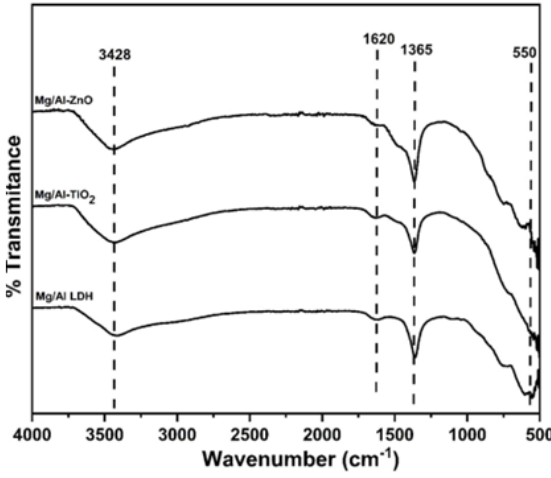
Fig. 9. FTIR spectra of catalysts after 5 th regeneration